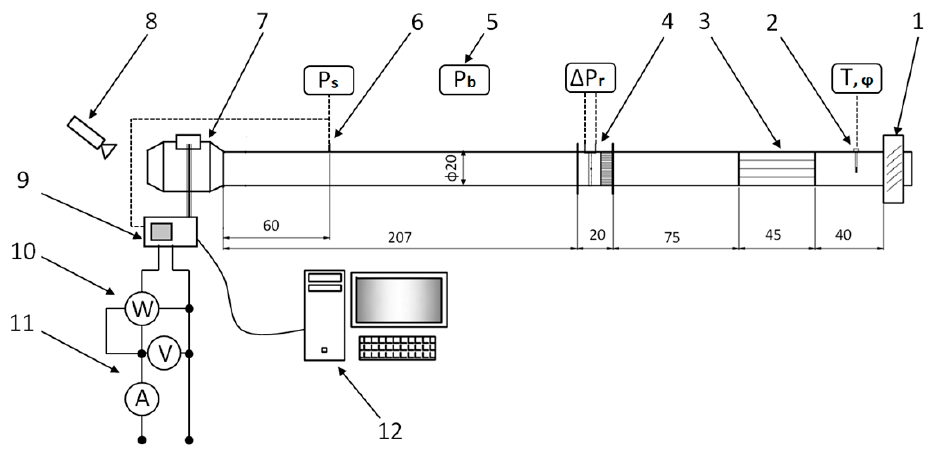
Figure 6. Installation for measurements of the e ffi ciency of the air-cooling system .